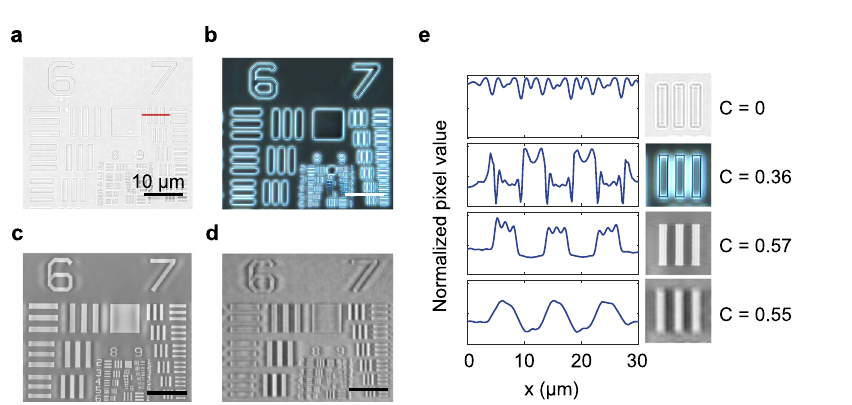
Fig. 4 | A quantitative comparison of conventional and NLM phase contrast images. a Bright fi eld image of a phase-contrast calibration sample. b Phase con- trast image of the calibration sample recorded with Zernike ’ s method. c , d . c Simulated,and d .experimentalphasecontrastimagestakenwiththeNLM. e Line pro fi lesofthebarsingroup7ofthecalibrationsample(indicatedbytheredlinein